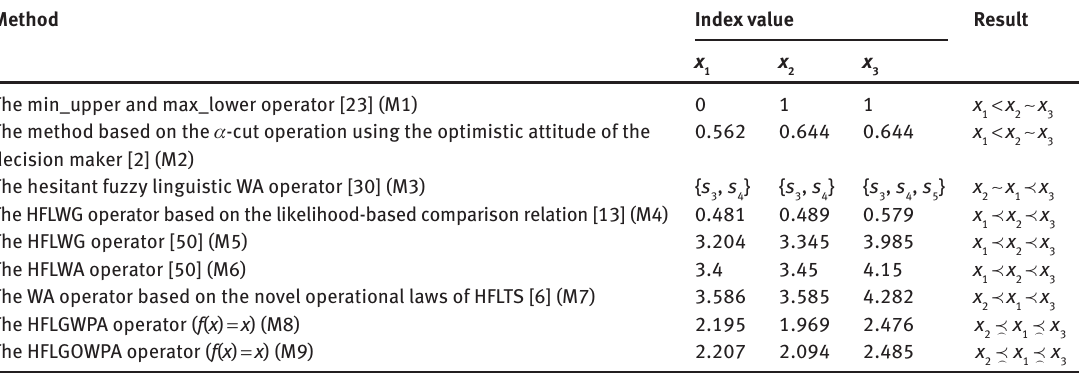
Table 9: Aggregated Results.